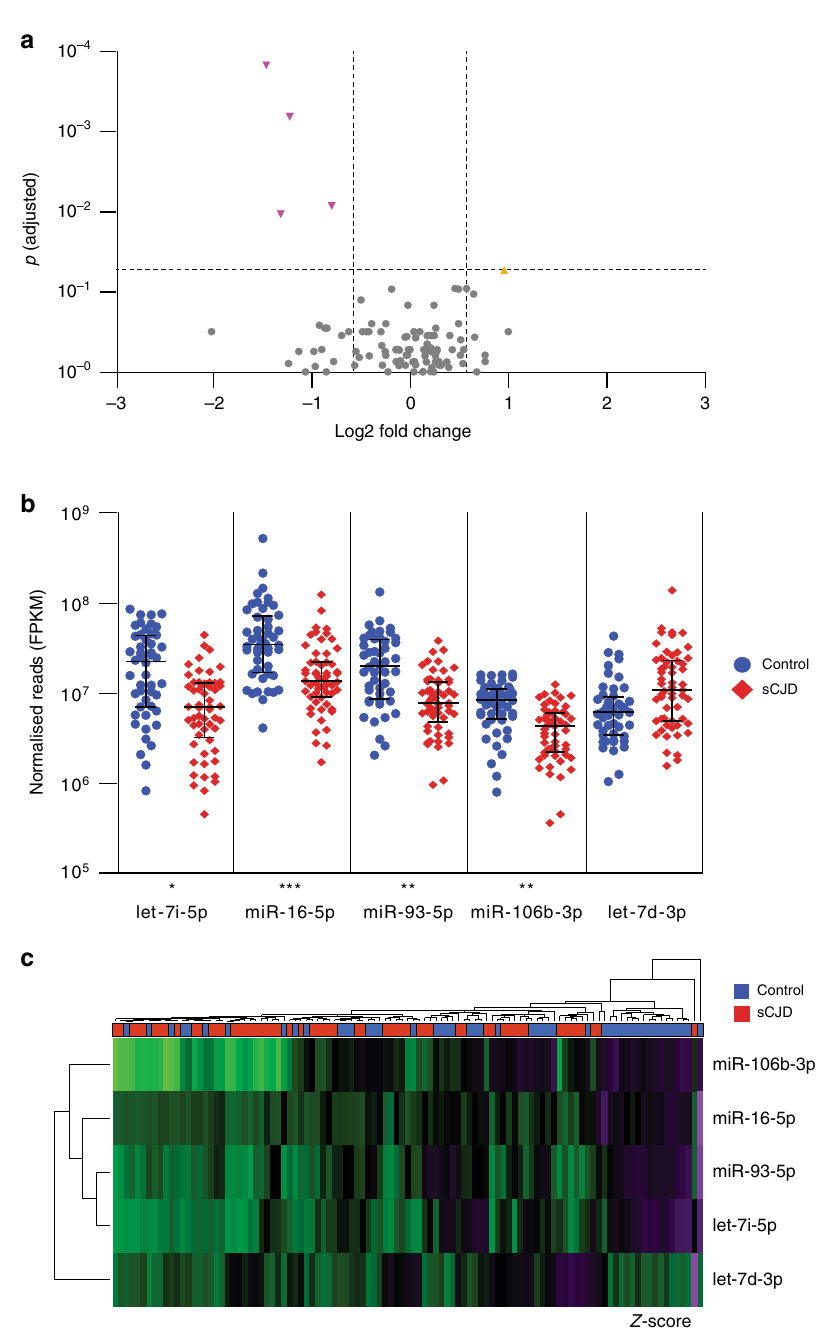
Fig. 1 Differential expression (DE) of miRNAs in the discovery cohort. Volcano plot of 101 miRNAs analysed for differential expression ( a ), vertical lines are shown to delineate >1.5 fold change; horizontal line to delineate adjusted p < 0.05. Adjusted p -values were generated using Partek ’ s Gene Speci fi c Analysis (GSA), and adjusted for multiple testing using the Benjamini – Hochberg false discovery rate (FDR) method. miRNAs followed up for validation and replication are shown by the yellow triangle (upregulated), and magenta inverted triangles (downregulated). Expression of DE miRNAs ( b ), plotted by normalised transcript count (in fragments per kilobase of transcript per million mapped reads, FPKM) with median and interquartile range are shown for both control and sCJD groups. p -values were generated using Partek GSA, and adjusted for multiple testing using the Benjamini – Hochberg FDR method. Fold change (FC) as follows: hsa-let-7i-5p FC − 2.49, p = 0.011; hsa-miR-16-5p FC − 2.76, p = 1.48 × 10 − 4 ; hsa-miR-93-5p FC − 2.34, p = 0.001; hsa-miR- 106b-3p FC − 1.74, p = 0.008; hsa-miR-let-7d-3p FC 1.94, showed borderline signi fi cance at p = 0.053. * p < 0.05, ** p < 0.01, *** p < 0.001. Control (blue circles) n = 48 biologically independent samples; sCJD (red diamonds) n = 57 biologically independent samples. Hierarchical clustering of DE miRNA pro fi les ( c ), illustrating relationships between both DE miRNAs, and individuals within the discovery cohort. Control (blue) n = 48 biologically independent samples; sCJD (red) n = 57 biologically independent samples. Source data for ( a ) and ( b ) are provided as a Source Data fi